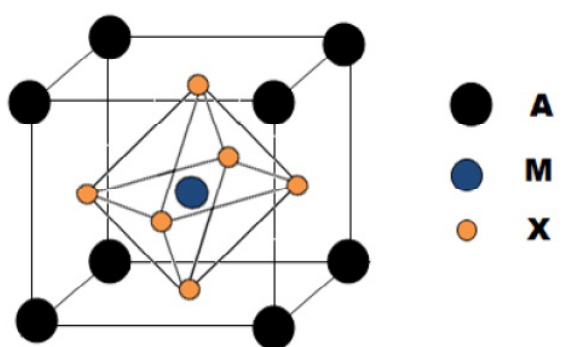
Fig. 1. Crystal structure of perovskite (AMX